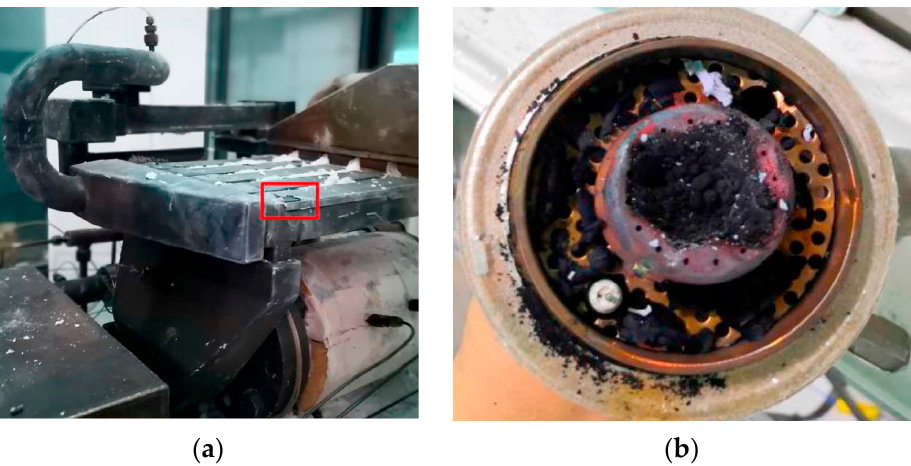
Figure 8. Failures occurring in SOFC systems: ( a ) Heat exchanger rupture. ( b ) Reformer carbon deposition. Reprinted with permission from Ref. [2].